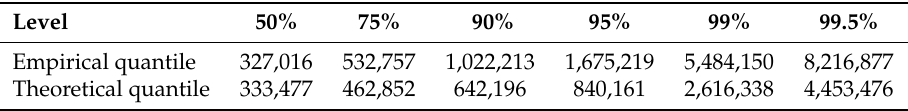
Table 4. Comparison between empirical and Lognormal–KumPareto